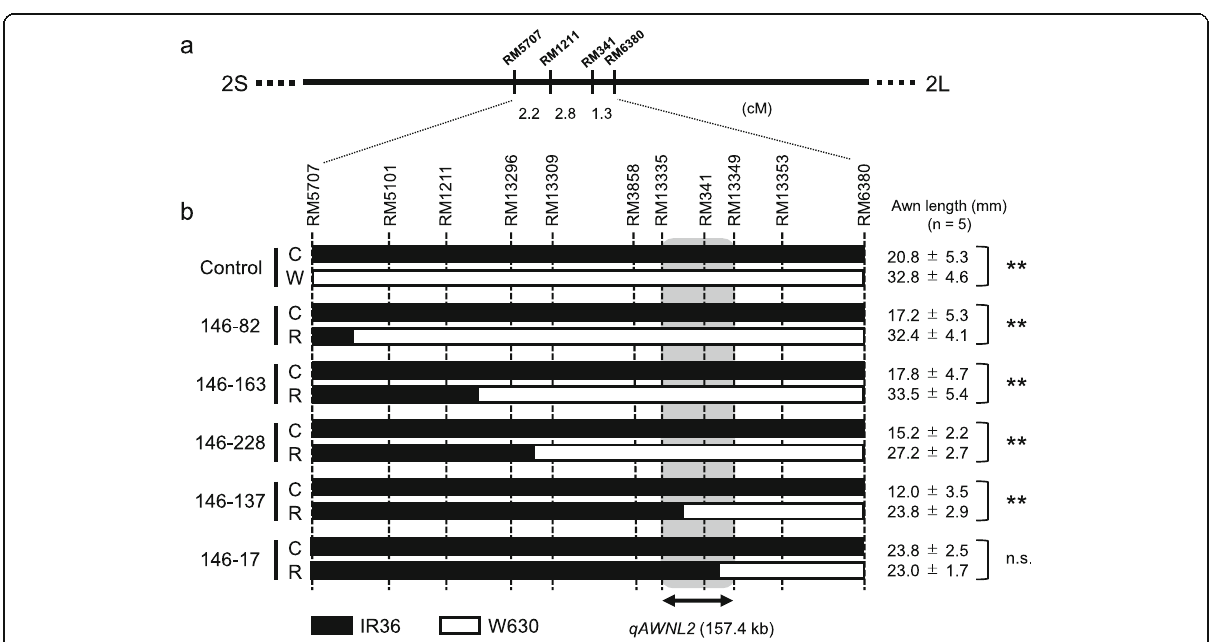
Fig. 4 Fine mapping of qAWNL2 . a Molecular markers between RM5707 and RM6380 on chromosome 2 were used to detect recombinants near the qAWNL2 locus. b Graphical genotypes of BC 3 F 5 lines derived from five critical recombinant BC 3 F 4 plants (nos. 146 – 82, − 211, − 228, − 137 and − 17) in the candidate region of qAWNL2 . C, W and R: Homozygous IR36, W630 and recombinant chromosomes, respectively. Awn lengths (means ± SD, n = 5) of the 5th spikelets of the BC 3 F 5 lines are shown on right. ** and n.s.: significant at P < 0.01 and not significant, respectively. The qAWNL2 locus was estimated in the 157.4-kb region between RM13335 and